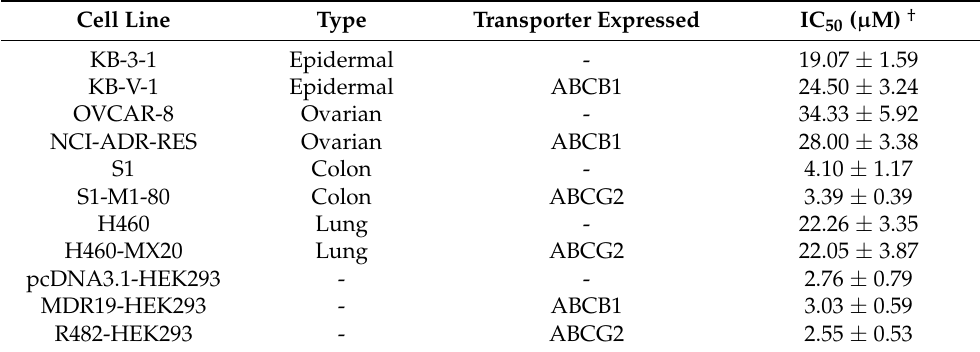
Table 1. Sensitivity of drug-sensitive and multidrug-resistant cells overexpressing ABCB1 or ABCG2 to